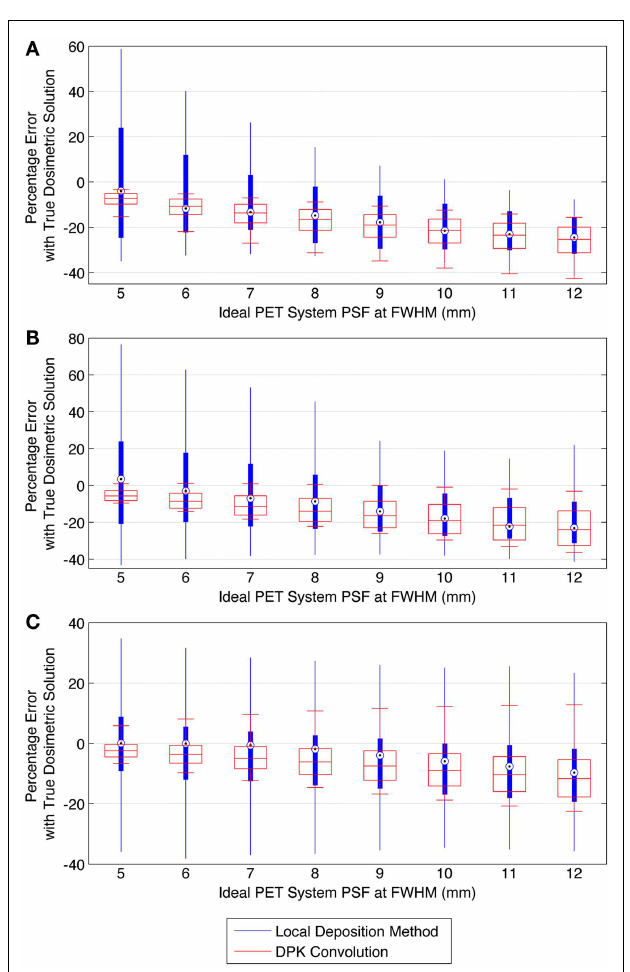
FIGURE 9 | Comparison of error using LDM or DPK convolution with theTDS based on mathematical phantoms with no noise and ideal PET scanner PSF for a 4mm isotropic voxel size . For each simulated PSF, percentage errors between either the LDM or DPK DVH and theTDS DVH for every dose ( D ) in the DVH were computed. Boxplots indicate mean error, 25th and 75th percentile of the distribution as well as upper and lower extremes across all doses, D . (A) 10mm hot-sphere, (B) 17mm hot-sphere, and (C) 37mm